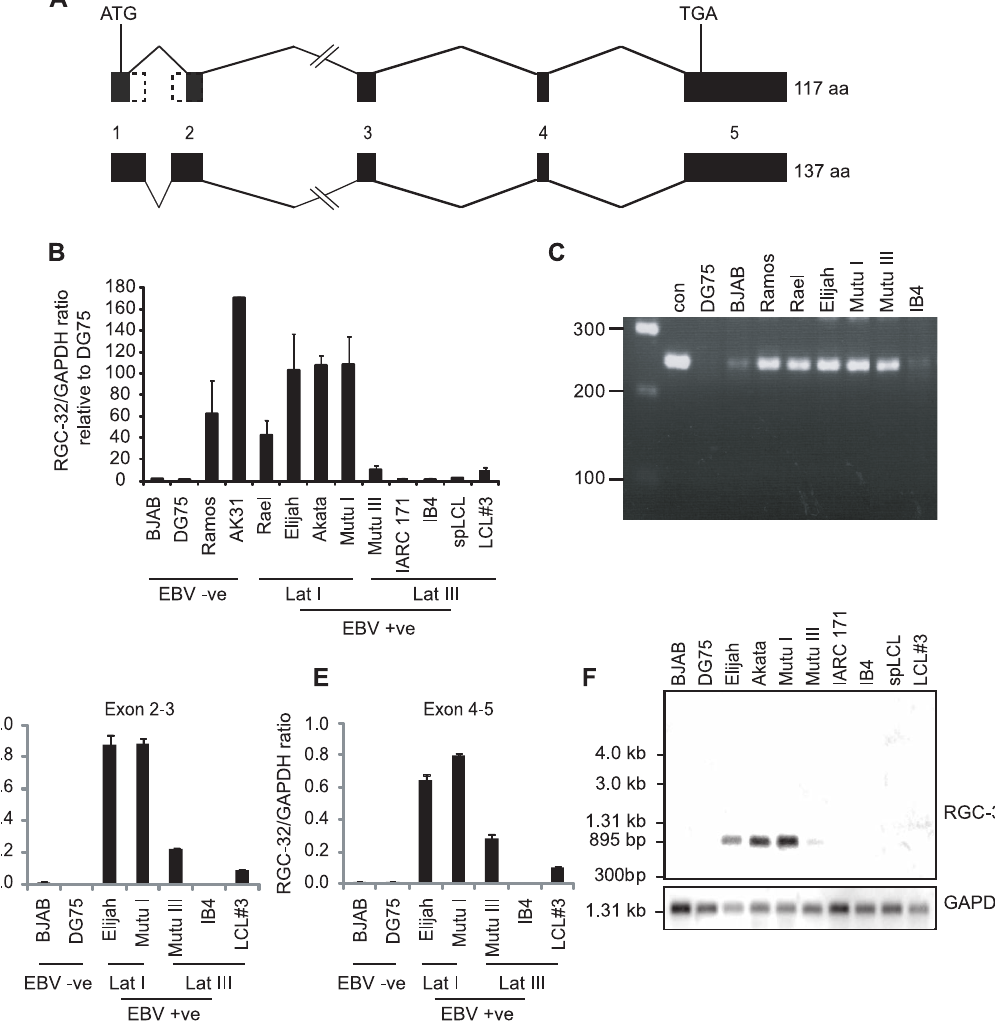
Figure 3. RGC-32 mRNA expression is differentially regulated in different types of EBV latency. (A) Diagram showing RGC-32 transcript variants. Black boxes represent exons and dotted lines show the parts of exons 1 and 2 that are not included in the shorter RGC-32 transcript (AF036549) that encodes a protein of 117 amino acids [28]. The longer RGC-32 (C13ORF15) transcript (NM_014059) is predicted to encode a protein of 137 amino acids. (B) Q-PCR analysis using primers in exon 3. Transcript quantities were normalized to those of GAPDH and then expressed relative to the signal obtained in DG75 cells. Results show the mean of 3 independent experiments + / 2 standard deviation. (C) Non-quantitative PCR analysis of cDNA samples using primers that amplify across exon 2 to exon 4. pFLAG-RGC-32 was used as a positive control (con). Q-PCR analysis using primers that amplify across exons 2 and 3 (D) or exons 4 and 5 (E). Transcript quantities were normalized to GAPDH and results show the mean of 3 independent experiments + / 2 standard deviation. (F) Northern blot analysis of RGC-32 transcripts. Blots were probed with a [ 32 P]-labelled probe generated from the entire RGC-32 cDNA and then stripped and re-probed for GAPDH.